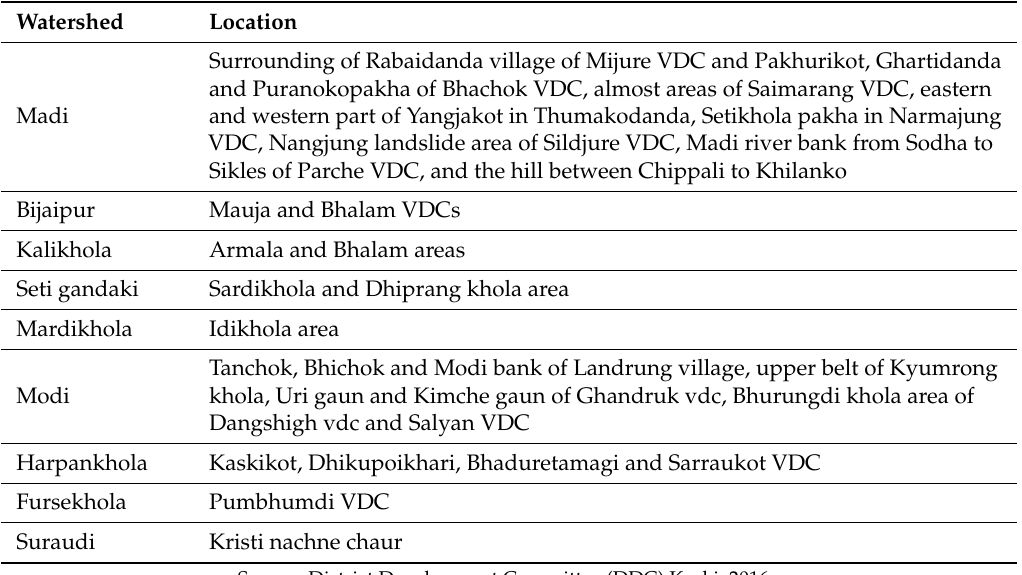
Table 4. Landslide hazard prone areas of Kaski